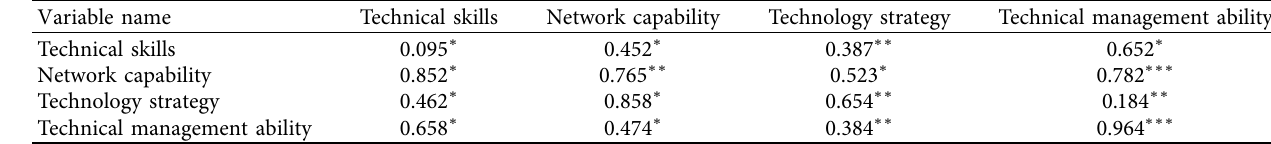
Table 1: The incentive effect of independent innovation paths on the development trend of emerging marine industries. Variable name